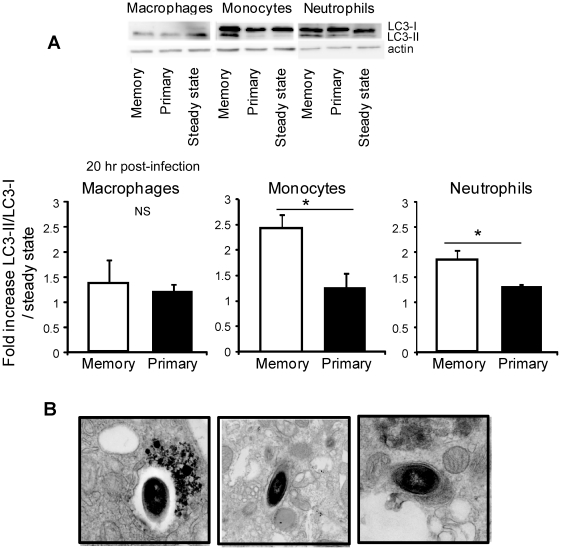
The reactive oxygen species generated inside inflammatory monocytes and neutrophils from memory mice induce autophagy.(A) Primary (black bars) and memory mice (white bars) (25/group) were challenged or not with 3×105 wt-L029 Lm. 20 hrs after the infection, spleen cells (from 5 mice/group) were pooled, and flow-sorted inflammatory monocytes, neutrophils and macrophages lysed and each lysate separated on 15% SDS–PAGE and subsequently analyzed with anti-LC3 and anti-actin mAbs (control). (A) Data show representative images (upper) and the quantification histograms (lower) depicting the fold increase of LC3-II/LC3-I ratios (mean +/− SE) measured for each condition and cell subsets compared to the steady state in a pool of 2 to 5 independent experiments. In (B) primary and memory mice (7/group) were challenged with 5×105 wt Lm expressing GFP. 20 hrs later, spleen cells (5 mice/group) were pooled and flow-sorted CD11b+GFP+ infected cells were fixed with glutaraldehyde, and analyzed by electron microscopy. Representative EM images of autophagosomes formation exhibiting double membranes around the bacteria are shown.